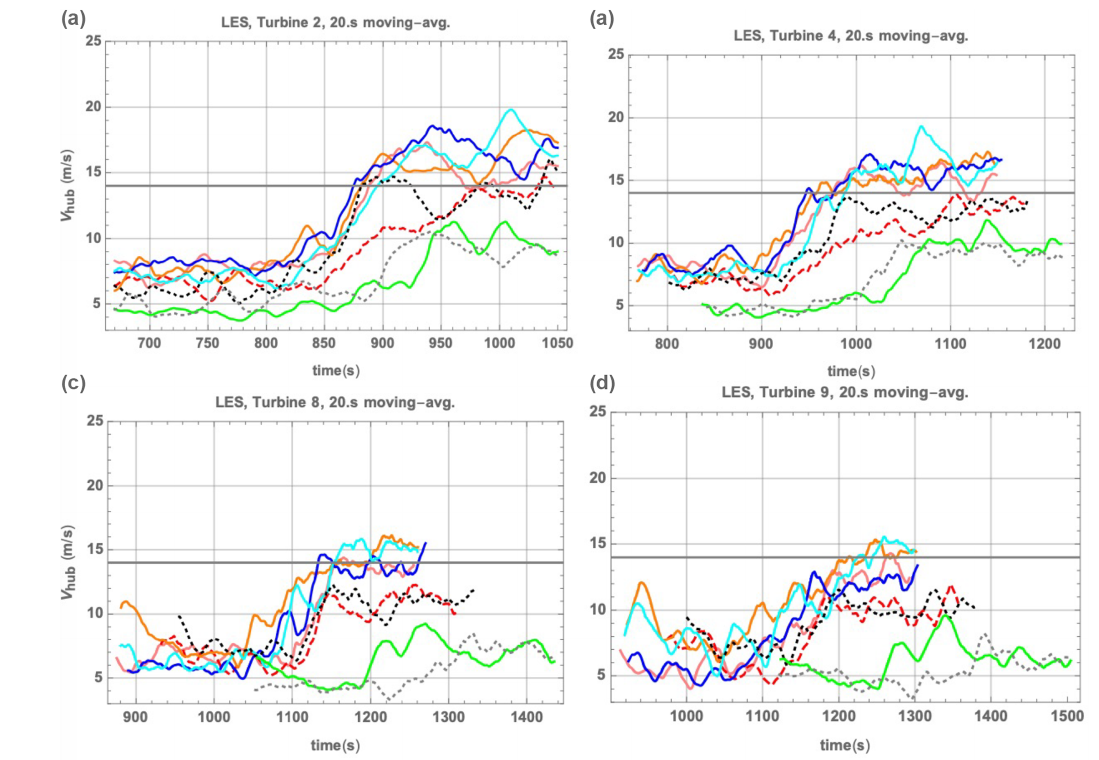
Figure 12. Wind-speed ramps at hub height in LES driven by constrained Mann-model simulation. (a) At the second turbine; (b) at the fourth turbine; (c) at the eight turbine; (d) at the ninth turbine. Color/case legend follows Fig.